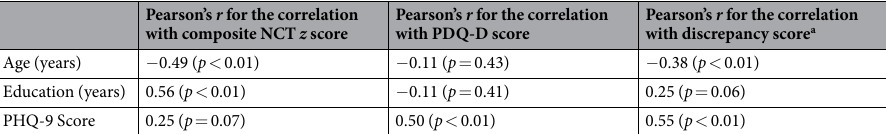
Pearson’s r for the correlation with discrepancy score a